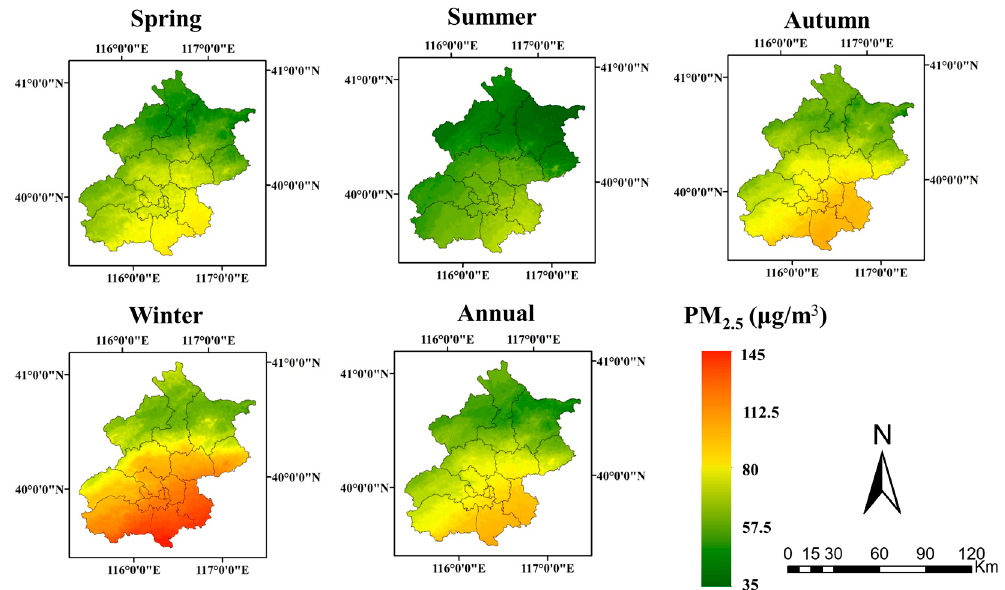
Figure 8. The spatial distribution of the seasonally and annually averaged PM 2.5 in Beijing.